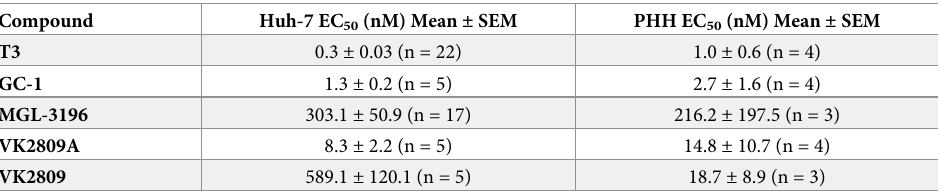
Table 2. Differential gene expression assay EC 50 values in Huh-7 cells and